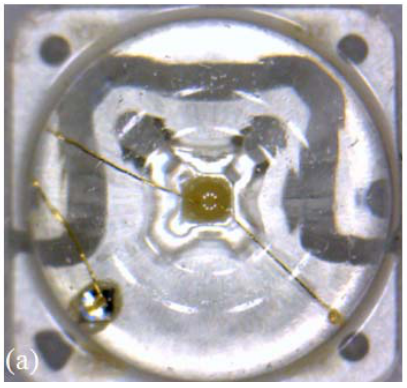
Figure 8. Circle chip LED. ( a ) Microscope top view 3D image; ( b ) 850 nm SD-OCT top view 3D movie 1; ( c ) 1,310 nm SS-OCT top view 3D movie